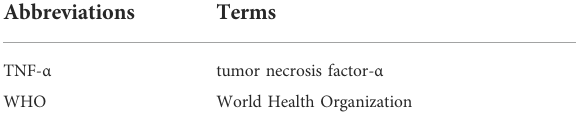
TABLE 1 Study on IL-6 in SARS-CoV-2, SARS-CoV and MERS-CoV.